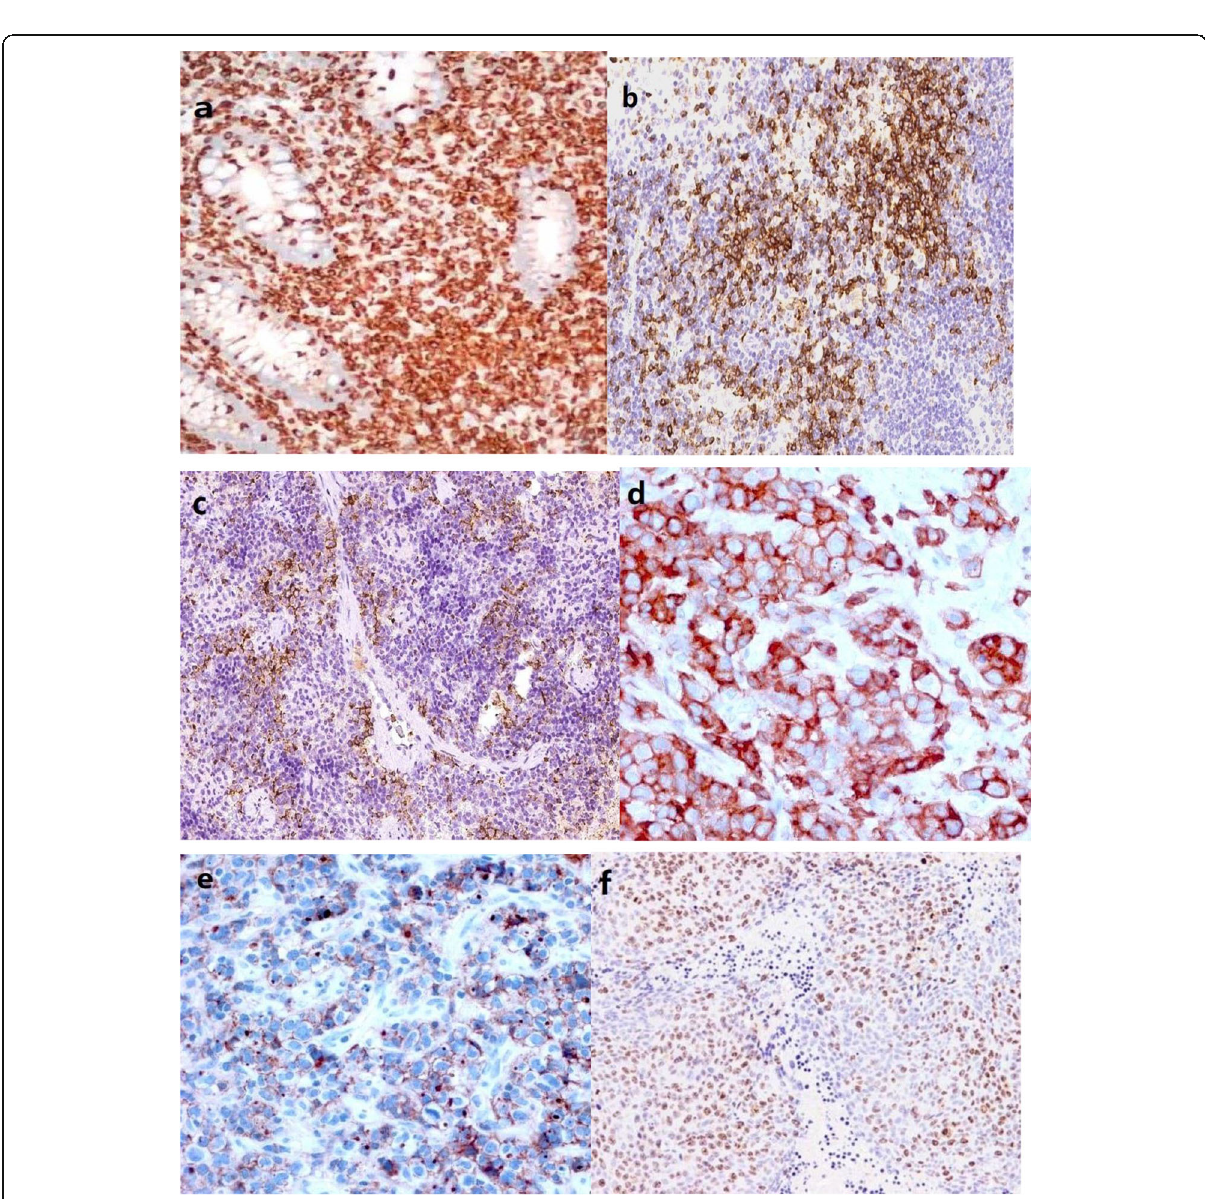
Fig. 3 Immunohistochemical positive results, ( a ) for CD3, ( b ) for CD7, ( c ) for CD8, ( d ) for TIA1, ( e ) for CD4, (f) for